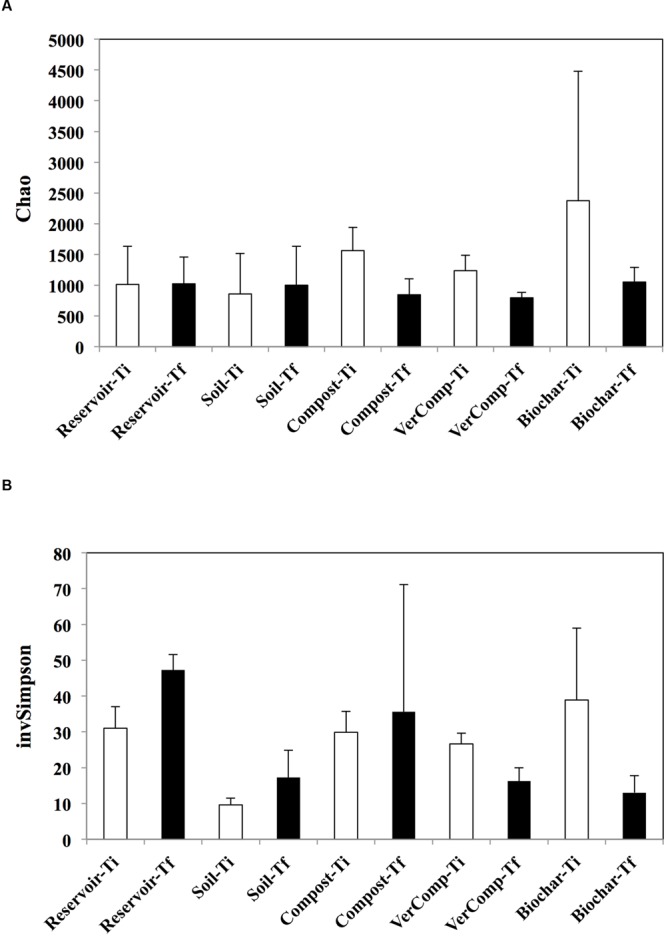
Estimated richness and evenness. (A) Chao index and (B) InvSimpson at Ti and Tf for all treatments. The mean and standard deviation is given for each treatment (n = 3).